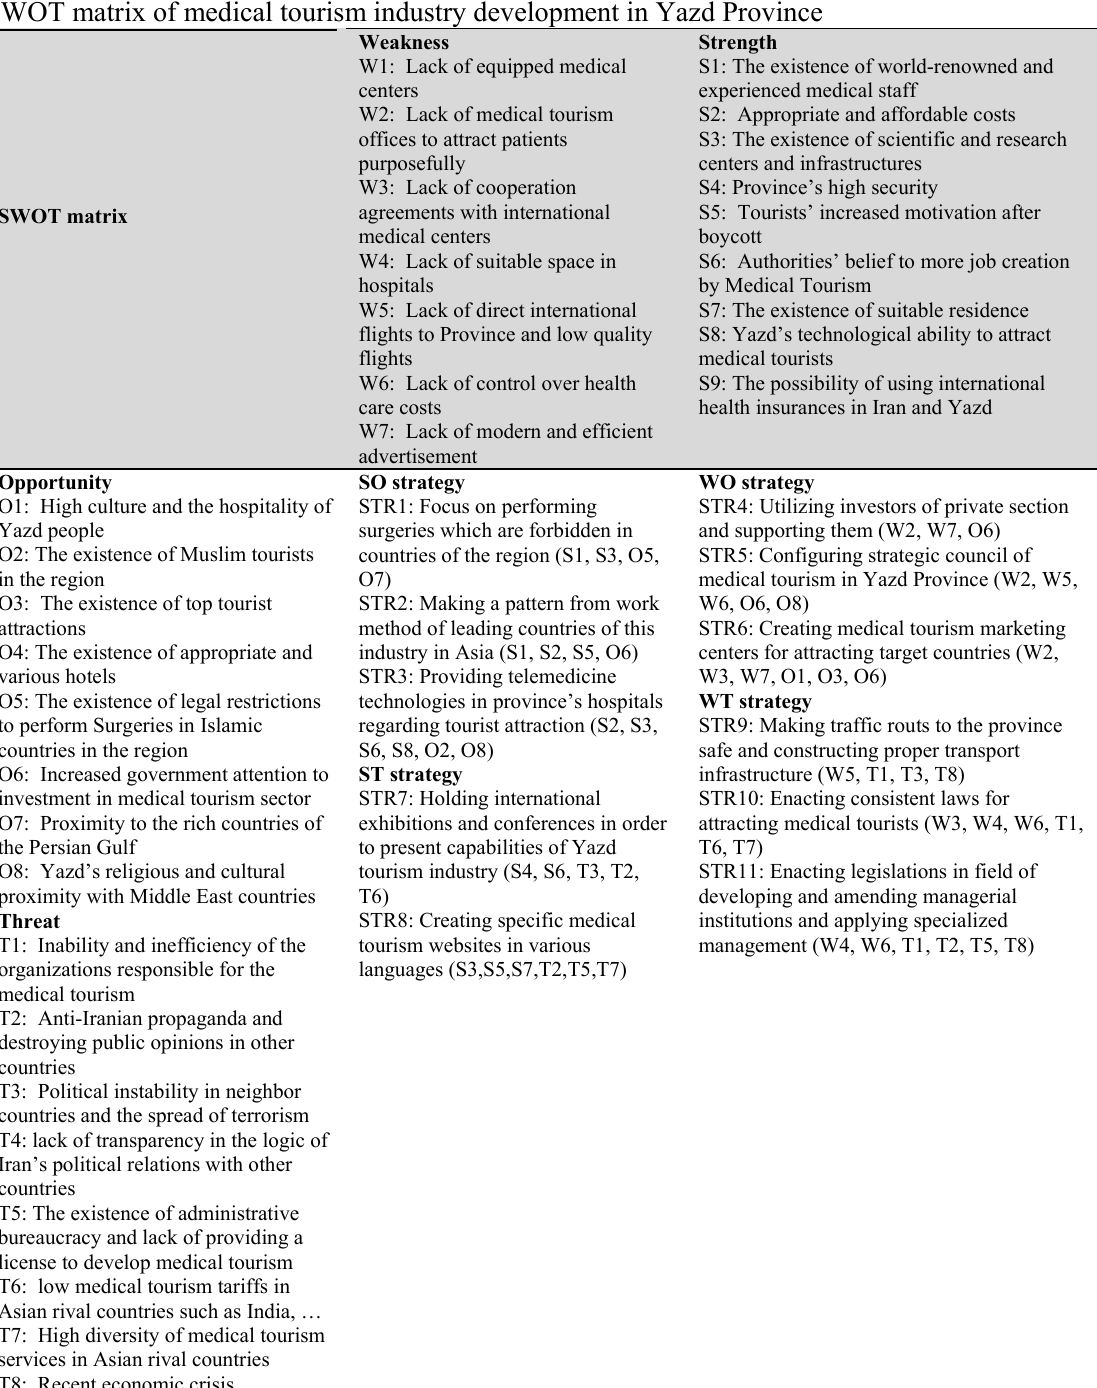
SWOT matrix of medical tourism industry development in Yazd